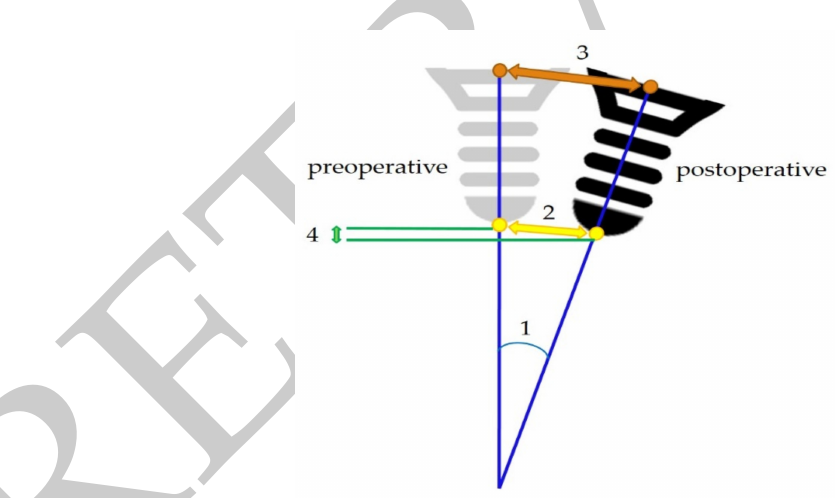
Figure 4. A schema for each deviation measurement from sagittal view: (1) angle deviation; (2) apical lateral deviation; (3) coronal lateral deviation; (4) vertical (depth)